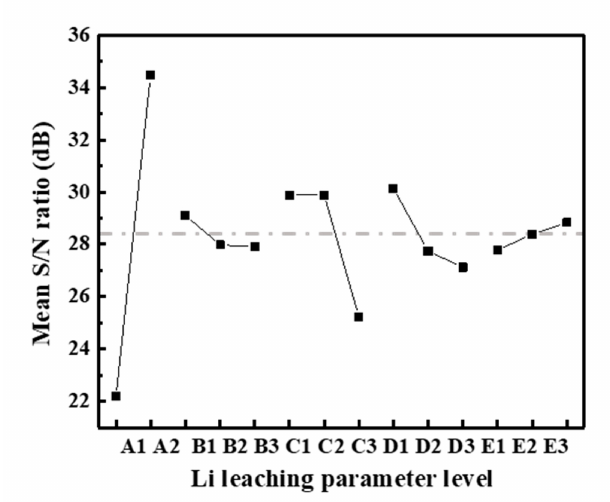
Figure 7. S/N graph for lithium leaching ratio.